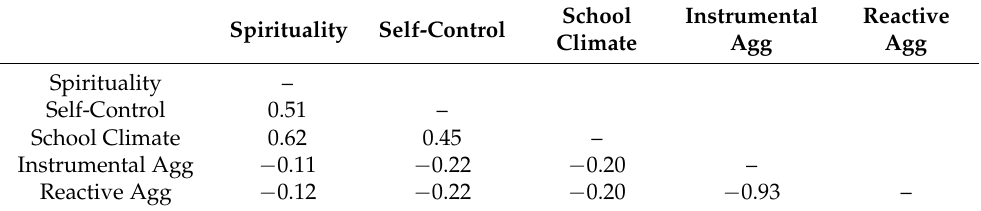
Table 2. Correlations between